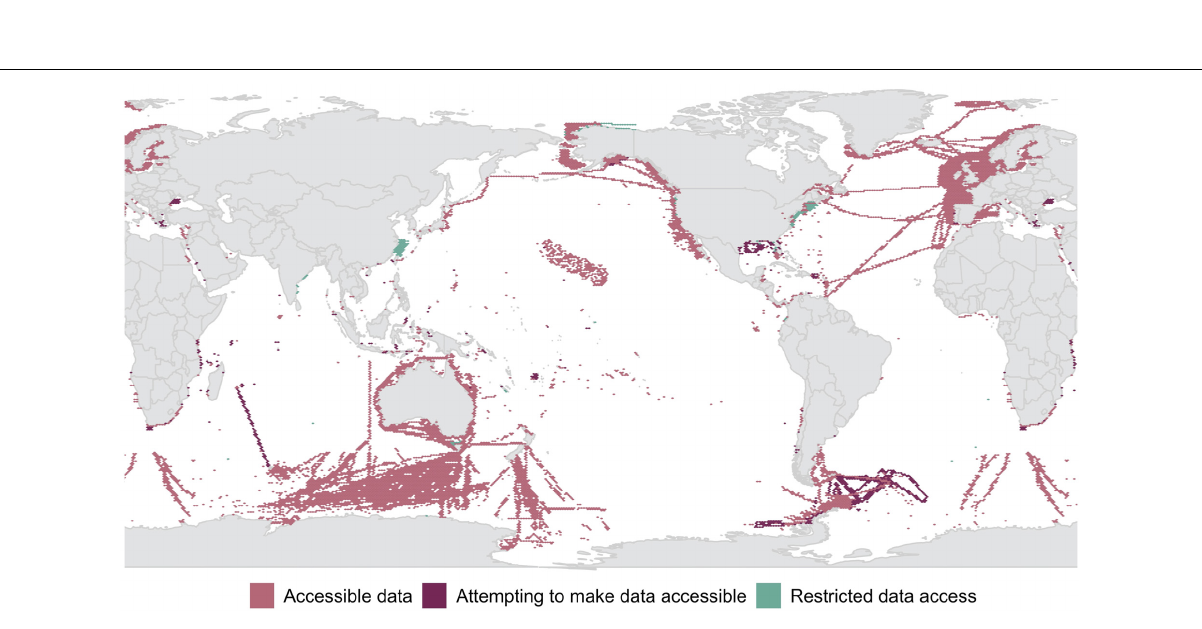
Frontiers in Marine Science |